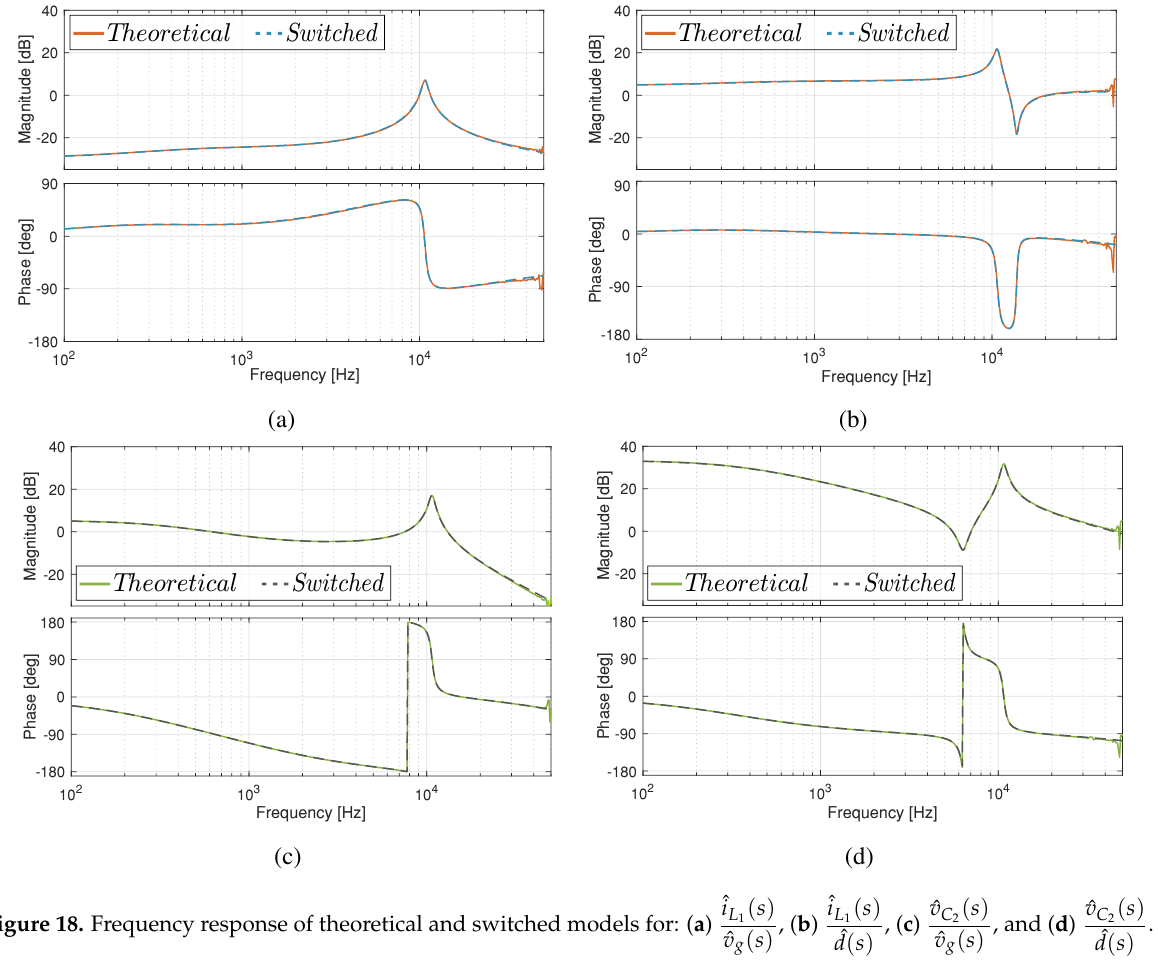
Figure 18. Frequency response of theoretical and switched models for: ( a )